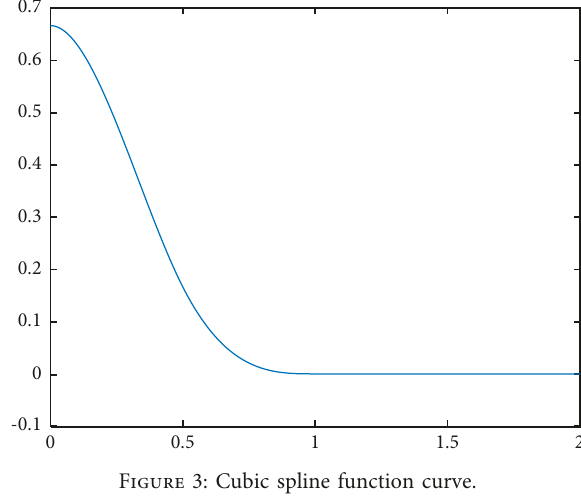
Figure 3: Cubic spline function